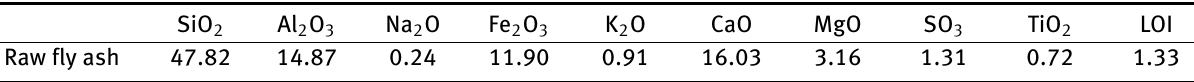
Table 1: The chemical compositions of the used raw fly ash.